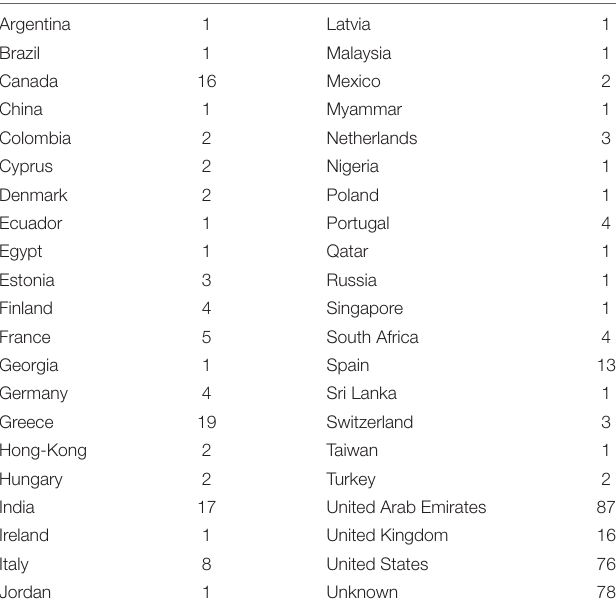
TABLE 1 | Breakdown of participants’